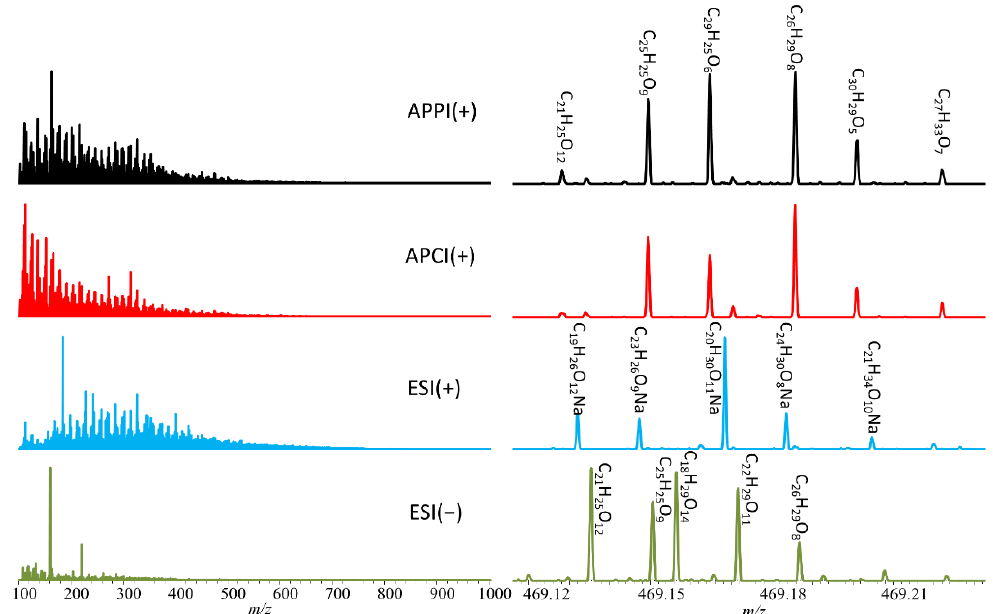
Figure 2. Comparison of mass spectra using multiple ionization techniques (left graph) and focused view of m/z 469.18 (right graph).